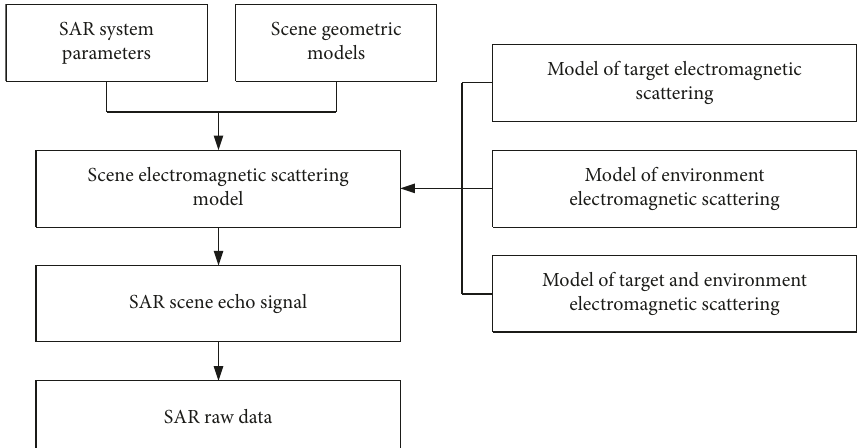
Figure 1: SAR simulation process-based electromagnetic scattering modeling.